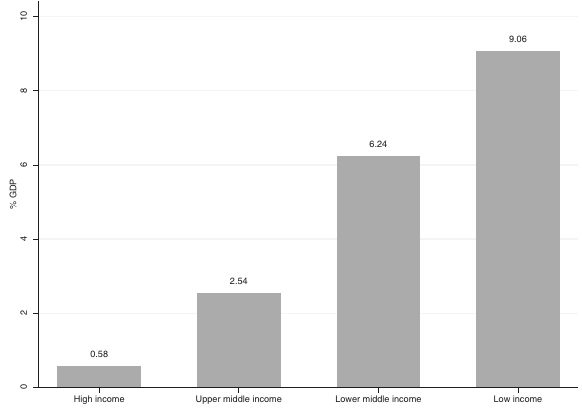
Fig. 3 Median COIs for not reaching SDG 4.2.2 for 1 year. Median simulated costs of inaction in terms of percentage of GDP loss of not reaching universal coverage for pre-primary programmes by World Bank country income group classi fi cation.